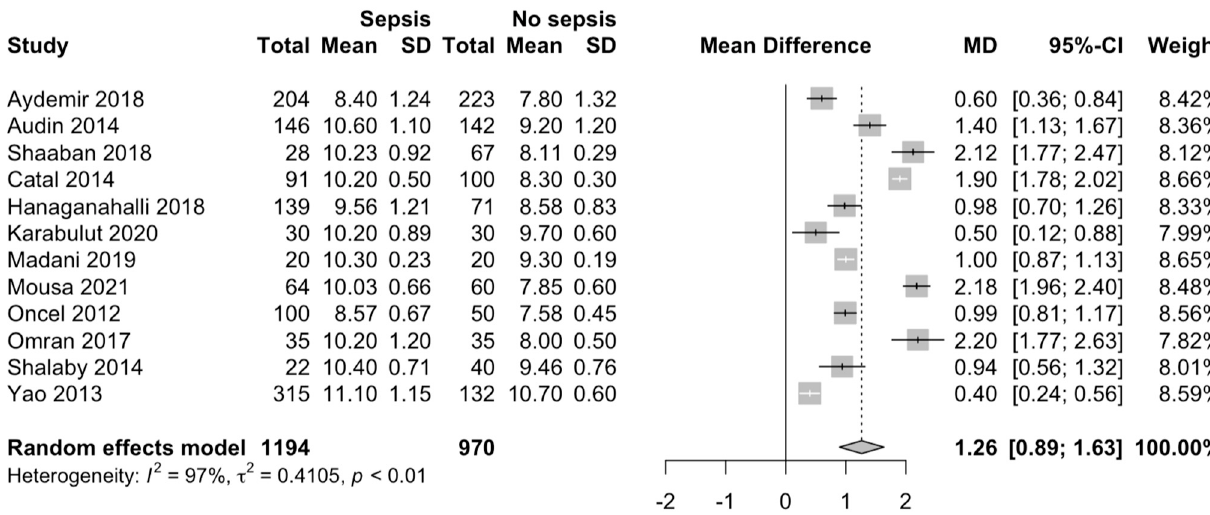
Figure 2. MPV in neonates with and without EONS [18–29].